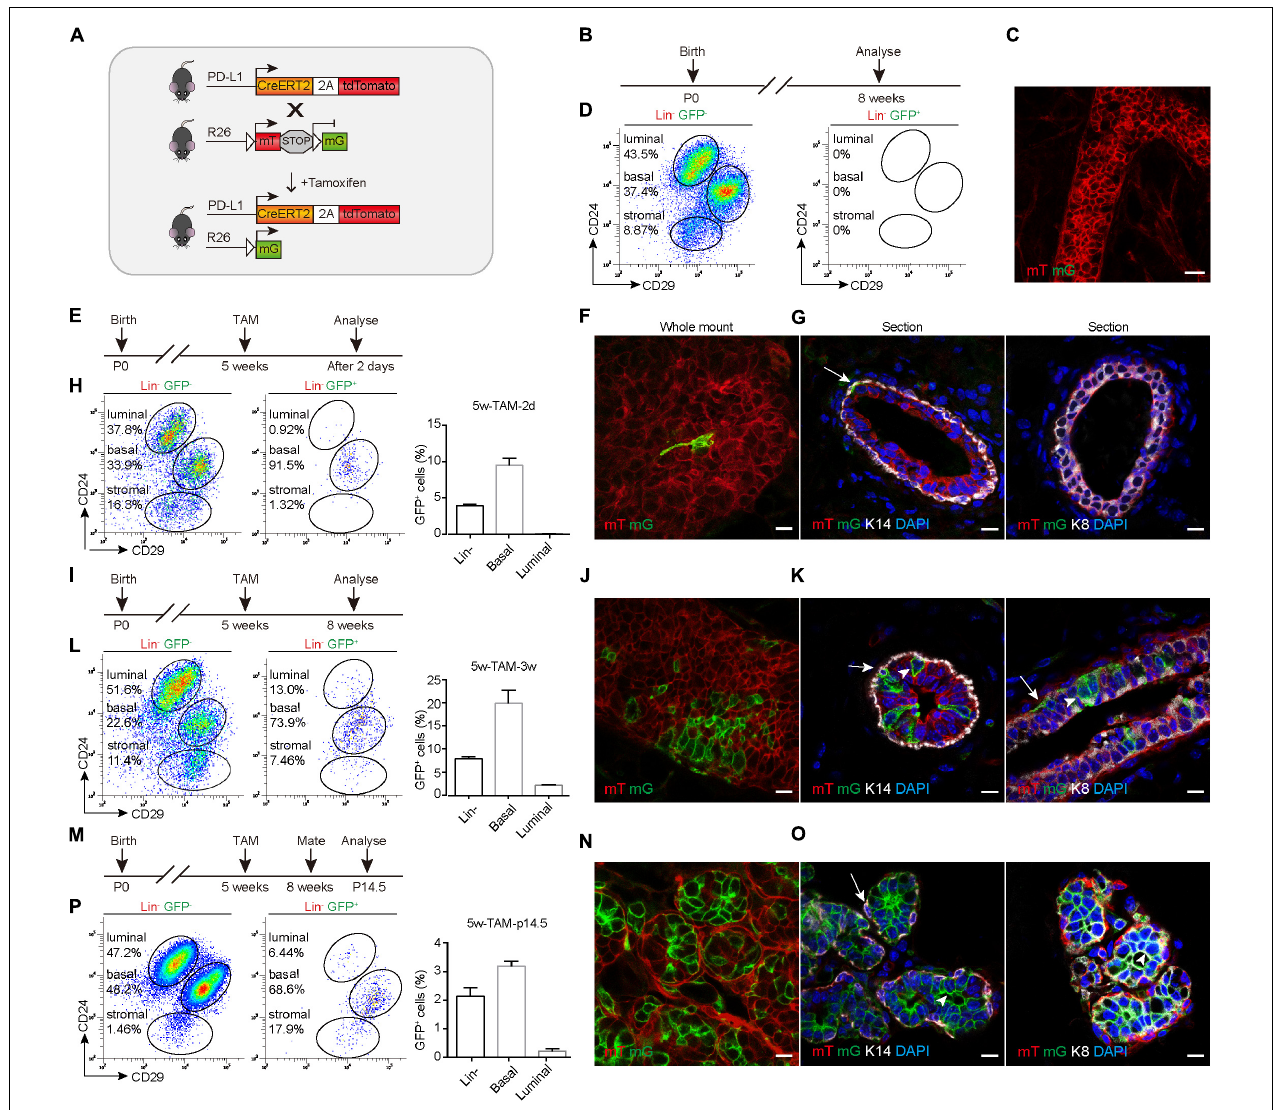
FIGURE 3 | PD-L1 + basal cells can produce basal, luminal, and alveolar cells during mammary development. (A) Illustration of the lineage-tracing strategy. (B) Control, uninduced mice. (C) Whole-mount confocal imaging analysis showing that no GFP + cells were present in the mammary ducts of uninduced PD-L1 CreERT2 − 2A − tdTomato / + ; Rosa26 mTmG / + mice. Scale bars, 20 µ m. (D) FACS analysis indicating that no GFP + cells were present in the mammary epithelium of uninduced mice. (E) Experimental design for the short-term tracing experiments; tamoxifen (TAM) was administered at the pubertal stage (5 weeks old). (F) Whole-mount confocal microscope images showing an elongated GFP + basal cell. Scale bars, 10 µ m. (G) Section imaging indicating the basal location of a GFP + cell. Scale bars, 10 µ m. (H) FACS analysis indicating that GFP + cells were mainly basal cells at 48 h after tamoxifen administration. (I–L) Experimental design for the long-term tracing experiments (I) , imaging (J,K) , and FACS analysis (L) of the distribution of the GFP + cells at 3 weeks after TAM administration. Scale bars, 10 µ m. (M–P) Experimental design for the long-term tracing experiments (M), Imaging (N,O) , and FACS analysis (P) of the GFP + cell distribution at pregnancy day 14.5. Scale bars, 10 µ m. K14 + cells are indicated by arrows. K8 + cells are indicated by arrowheads; n = 5 mice. FACS, fluorescence-activated cell sorting; PD-L1, programmed cell death ligand 1; GFP, green fluorescent